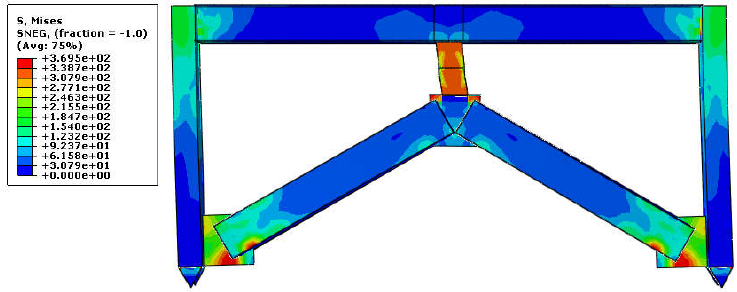
Figure 25. The stresses in the eccentrical braced frame.